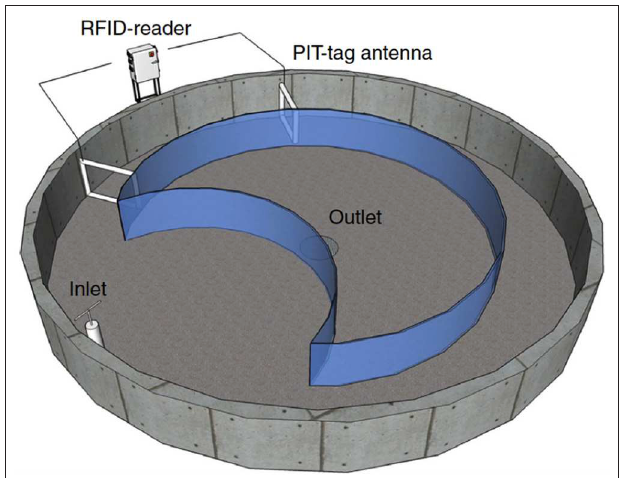
FIGURE 1 | Illustration of migration pool for laboratory migration study. Illustration re-printed with permission and adapted from Hellström et al.